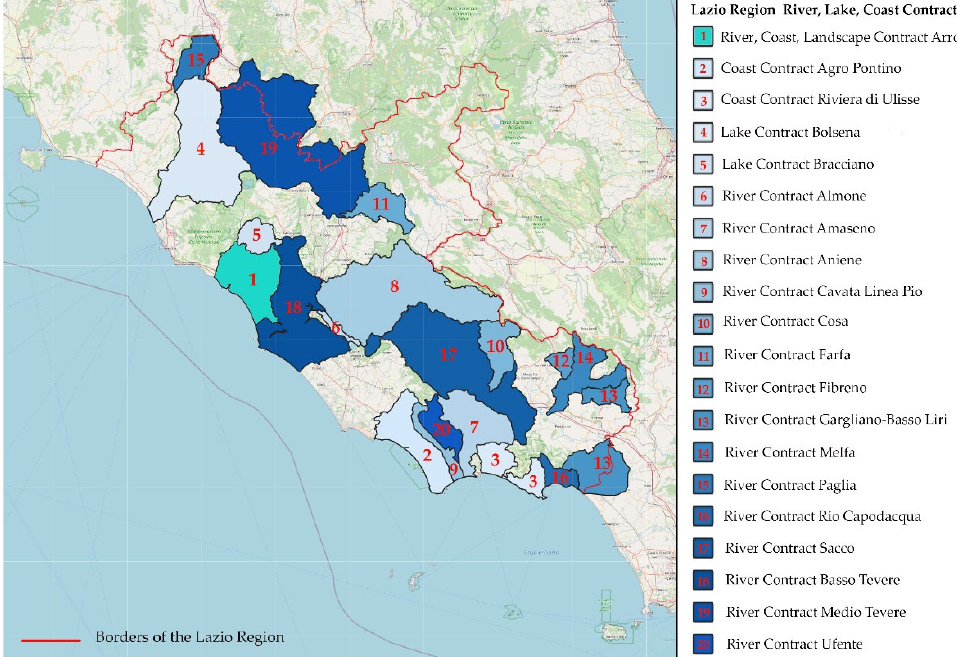
Figure 1. The localization of the Lazio Region River, Lake, Coastal Contracts, highlighting the case study of the River, Coast and Landscape Contract Arrone. Source: author’s elaboration (2022) from data of the River Contract Atlas available at https://progetti.regione.lazio.it/contrattidifiume/ atlante-dei-cdf/ (accessed on 30 June